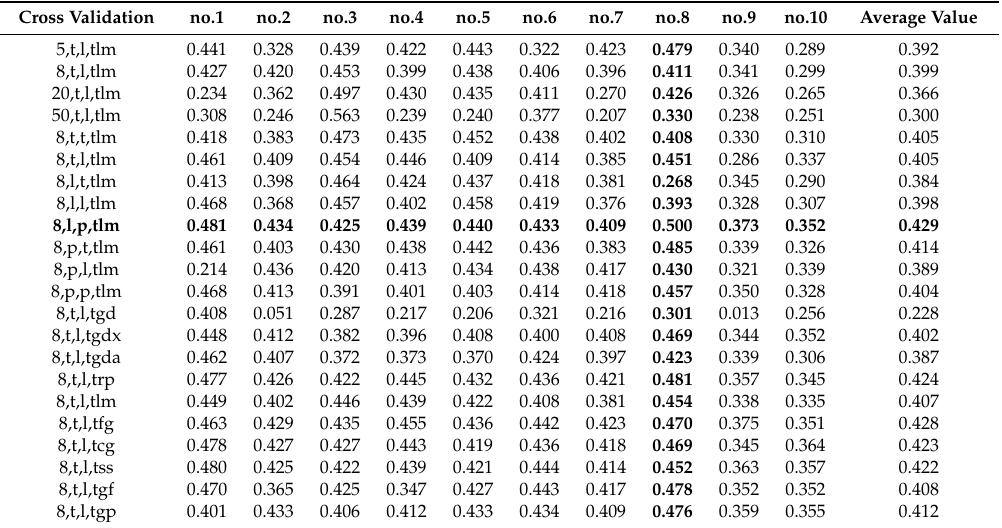
Table A1. Results (R 2 ) using different parameters in the BP-ANN